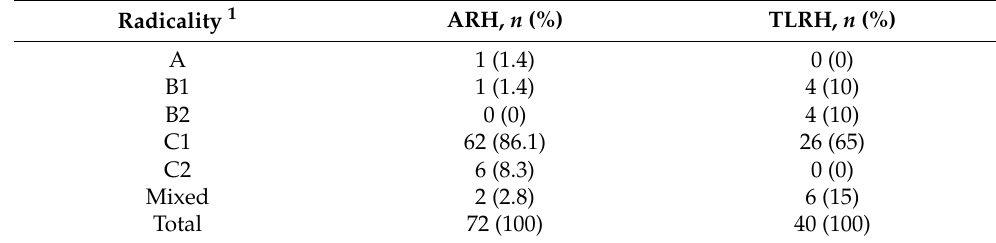
Table 1. Radicality of hysterectomy in women who underwent abdominal radical hysterectomy (ARH) and total laparoscopic radical hysterectomy (TLRH) for cervical cancer. Radicality 1